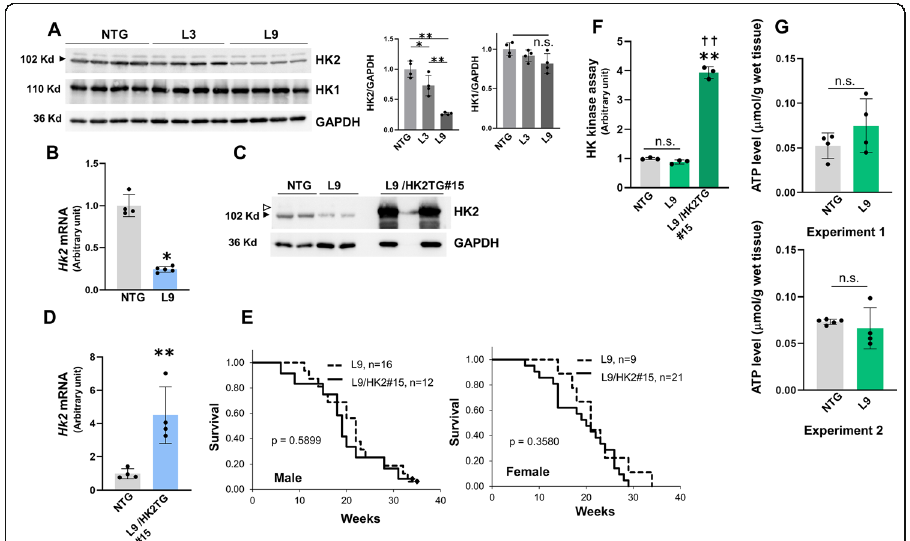
Fig. 3 Analysis of HK2 expression, HK activity and ATP content of α MHC/miR-143/145TG (L9) mice and characterization of α MHC/miR-143/145/HK2TG (L9/HK2) mice. a Whole cell extracts from the hearts of 3- month old male L3 and L9 mice were examined using the indicated antibodies. The right panels show the relative densitometric analysis of the western blots. The results are presented as the means ± SD. Significance was assessed with one-way ANOVA followed by a post hoc Tukey test (* p < 0.05, ** p < 0.01). b Quantitative RT-PCR analysis of Hk2 mRNA in the hearts of 3-month old male L9 mice. The results are presented as the means ± SD with the unpaired t -test applied to determine significance ( n = 4 ~ 5; * p < 0.05 vs. NTG). c Western analysis of HK2 in the hearts of 3-month old male L9 and L9/HK2 mice. Whole cell extracts were examined with an anti-HK2 antibody. The white and black arrowheads respectively indicate the transgenic human HK2 and the endogenous mouse HK2. d Quantitative RT-PCR analysis of Hk2 mRNA in the hearts of 3-month old male of L9/HK2 mice. Primers with common binding sites for human and mouse Hk2 genes were used. The results are presented as the means ± SD with the unpaired t -test